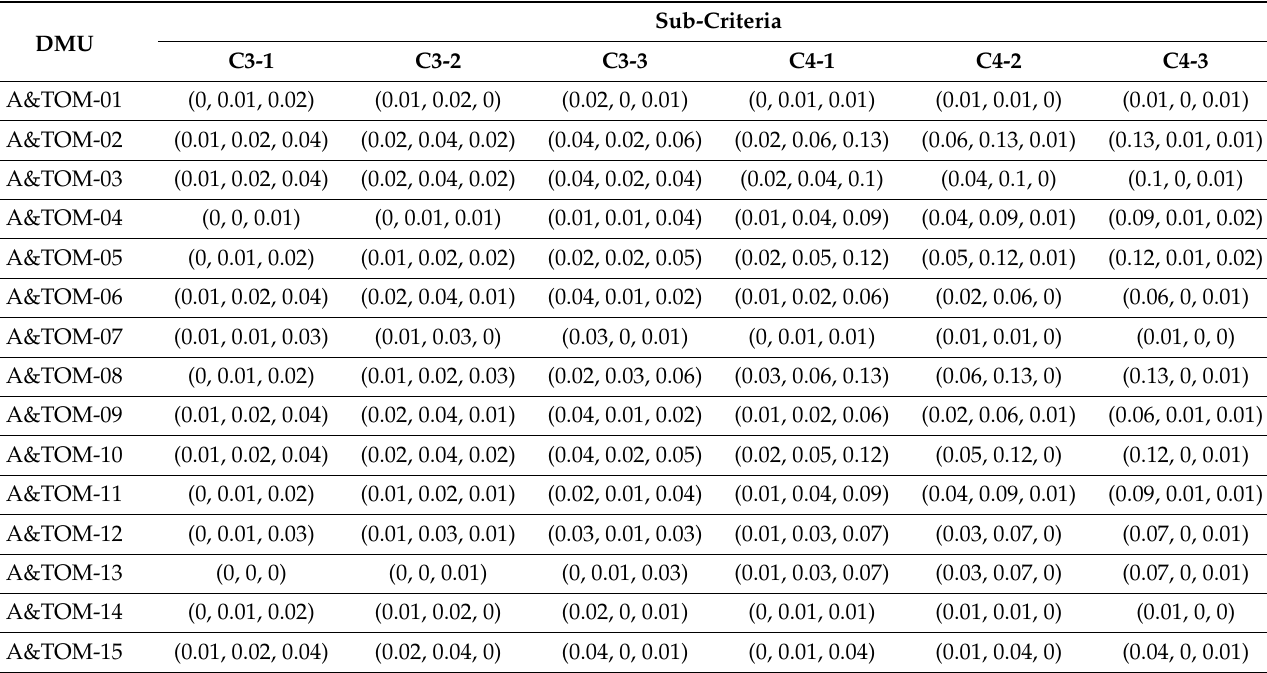
Table A4. Weighted normalized fuzzy decision matrix.